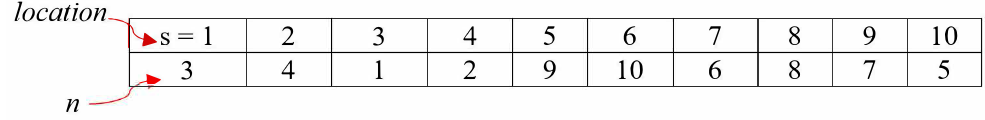
Figure 7. Solution